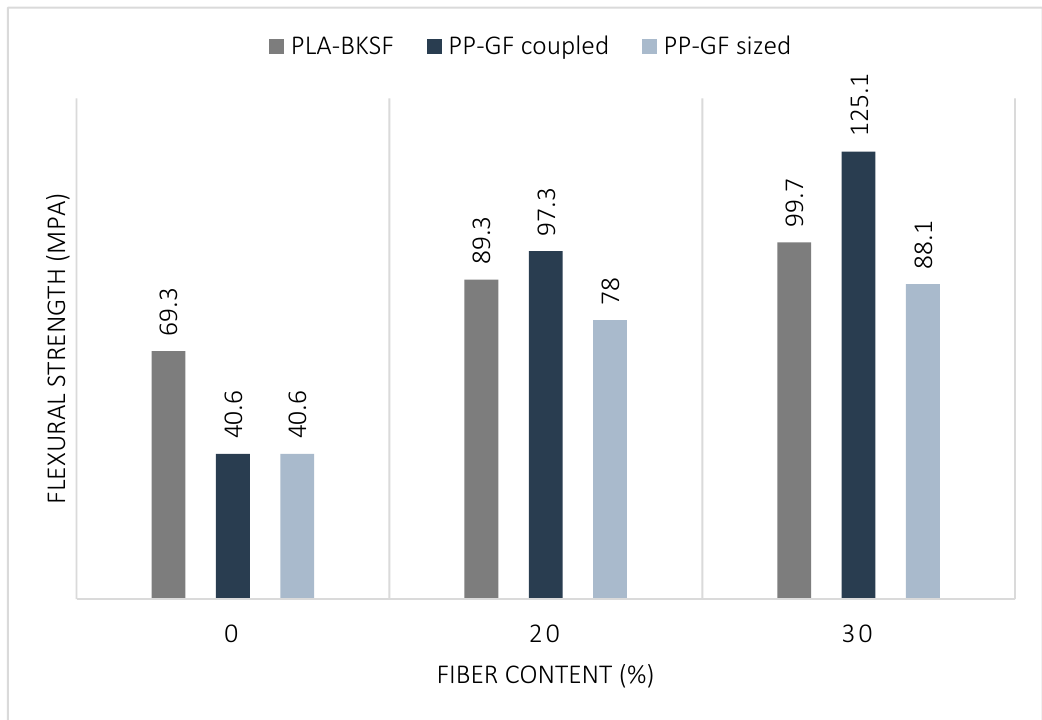
Figure 3. Comparison between PLA–BKSF and PP–GF composites.